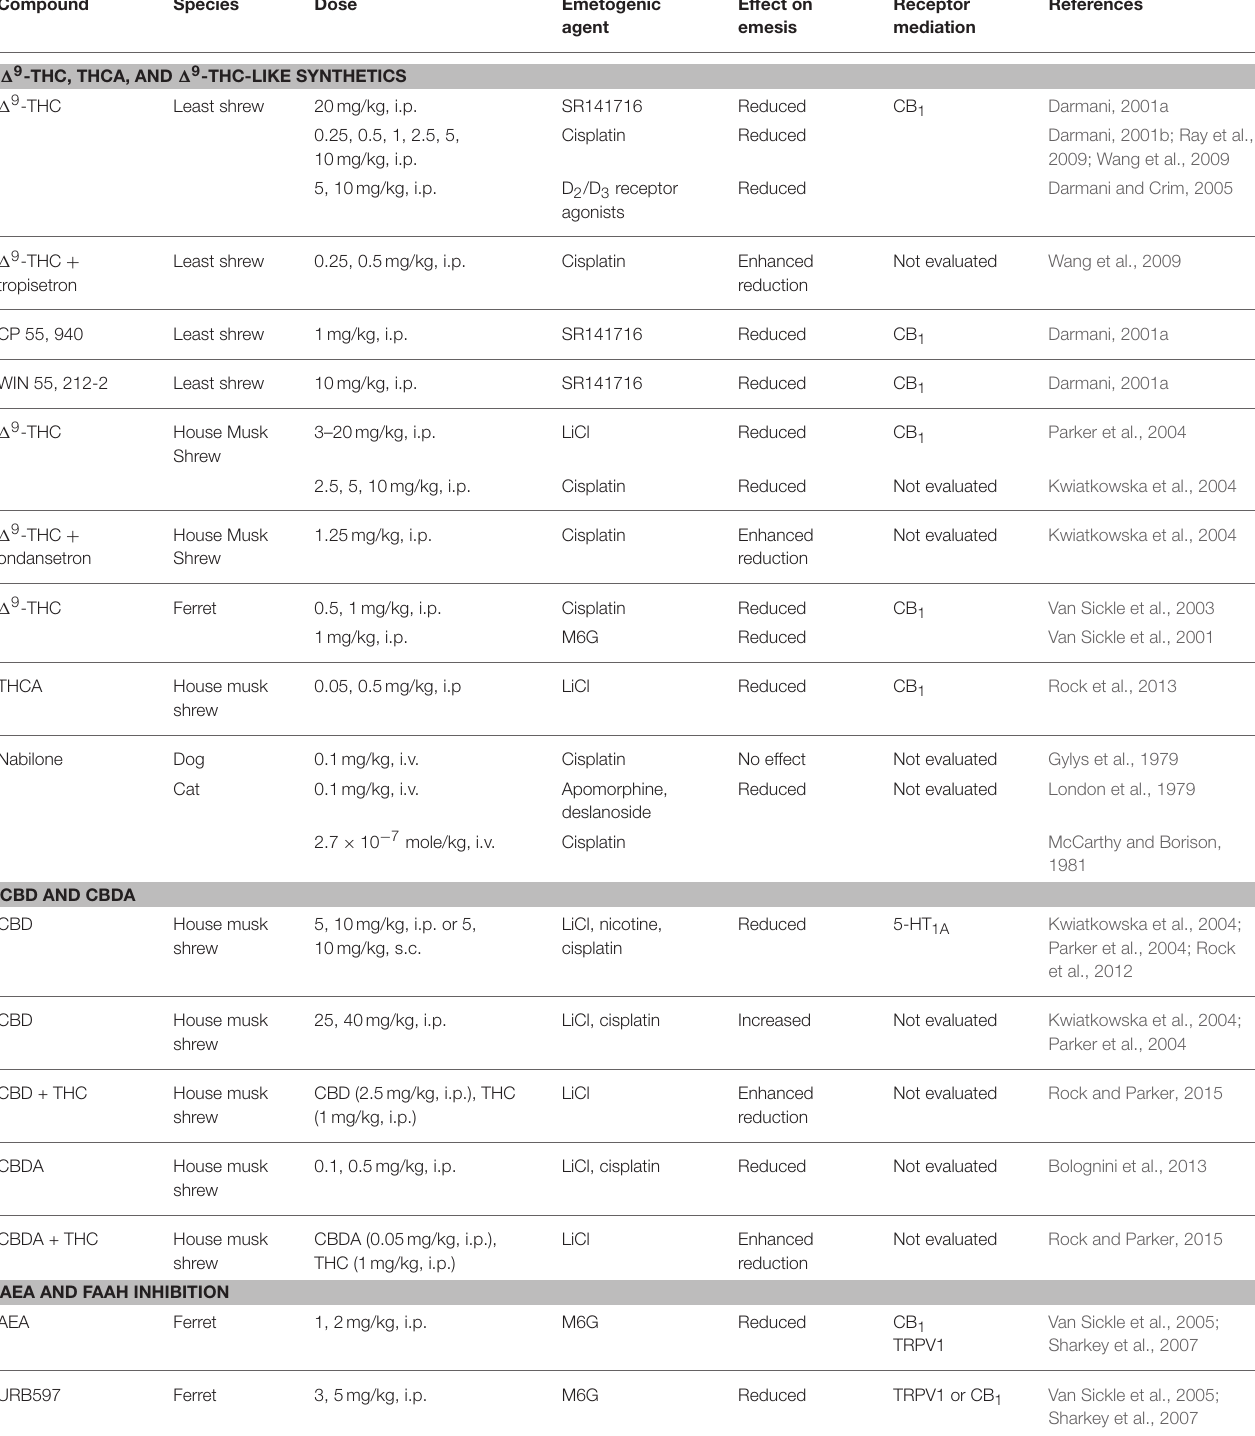
TABLE 1 | Effect of exogenous cannabinoids and manipulations of the endogenous cannabinoid system on vomiting in animal models.